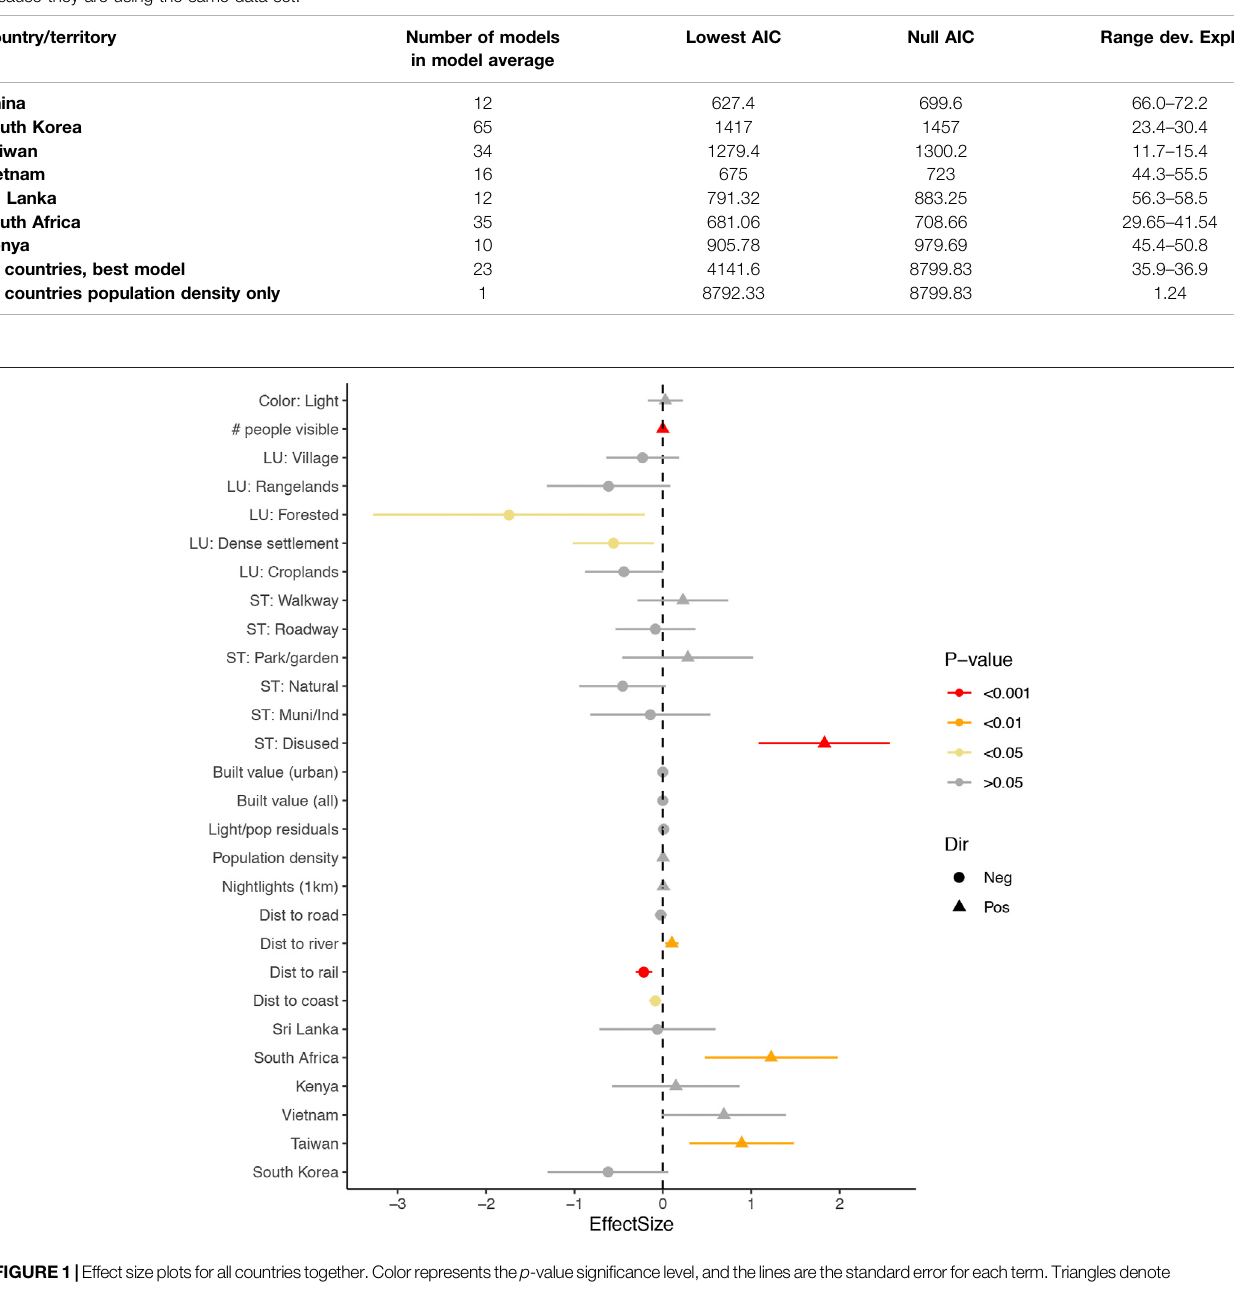
Frontiers in Environmental Science |